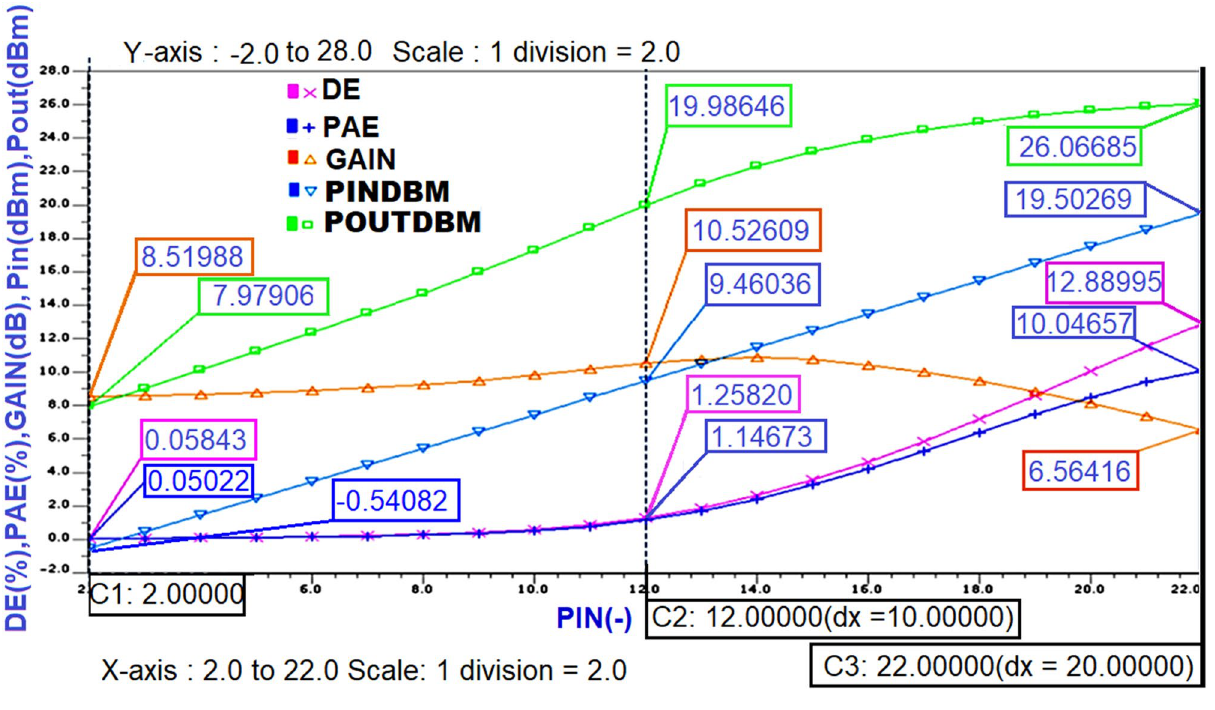
Figure 16. The performance parameters of Class-J PA with RF input at 5 GHz.